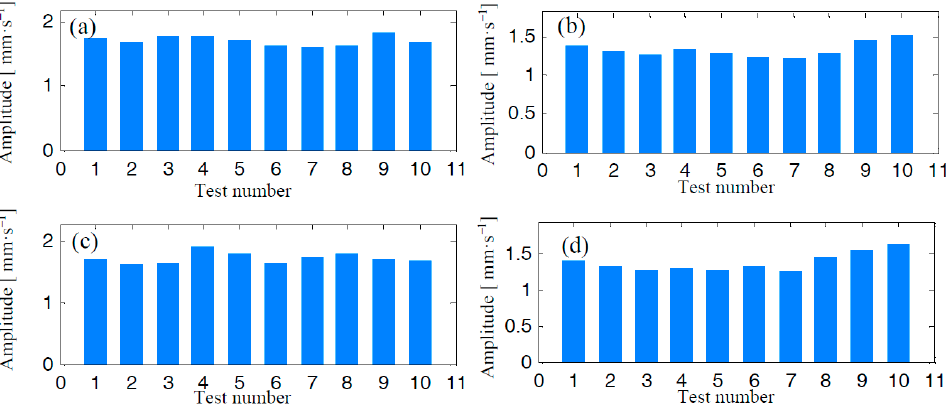
Figure 21. Kurtosis trends of the centrifugal compressor: ( a ) Channel ‘2A’, ( b ) Channel ‘2H’, ( c ) Channel ‘3A’, and ( d ) Channel ‘3H’.